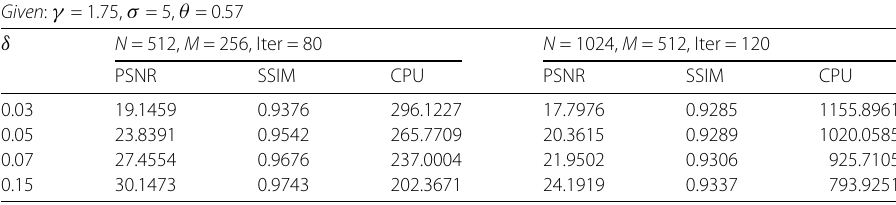
Table 10 Computational results for each